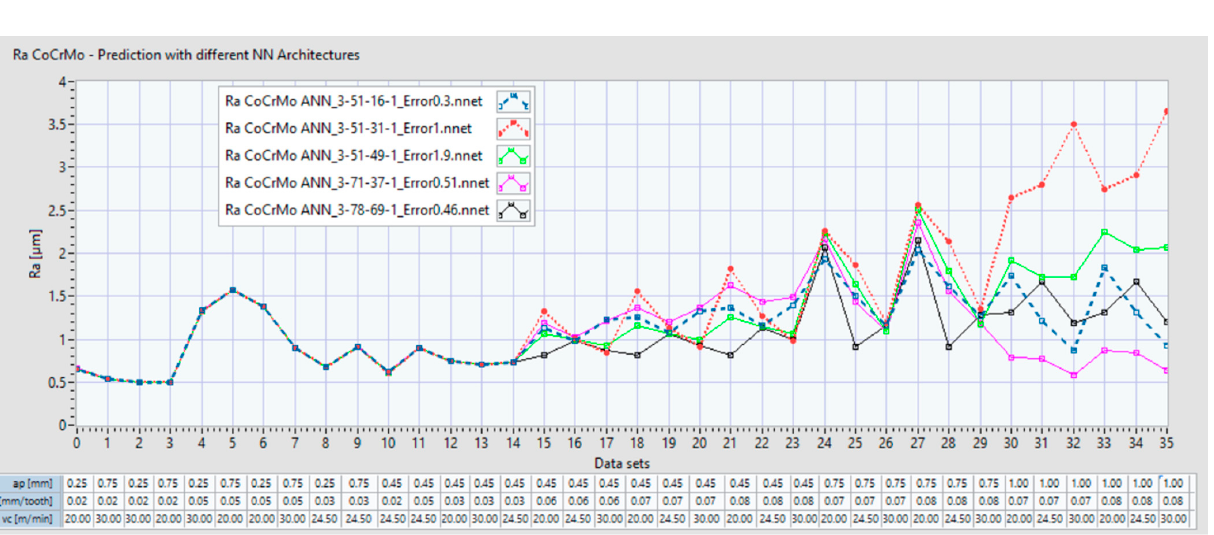
Figure 18. Prediction of Ra with 10 ANNs for Co-20Cr-15W-10Ni with a data set of 36 inputs. The ANN application software designed for this study is based on an architecture based on sub-Vis which can be extended and integrated in larger subsystems to cover predictive and adaptive roles in the design process of future products made from materi- als such as these alloys. Another direction of software development is to build ANN models based on more relevant input process parameters (independent variables) such as displacement of tool vibration, tool wear, etc. Increasing the number of variables as an input to an ANN may increase the accuracy of the predicted answers. 4. Conclusions Ra roughness is an important parameter in the evaluation of the quality of a ma- chined surface. Consequently, developing prediction models for this parameter is im- portant for improving the performance of the machining operation, product functionality and optimizing costs. Even if end-milling is not always the last operation performed in order to obtain the final characteristics prescribed for a certain surface, especially in regard